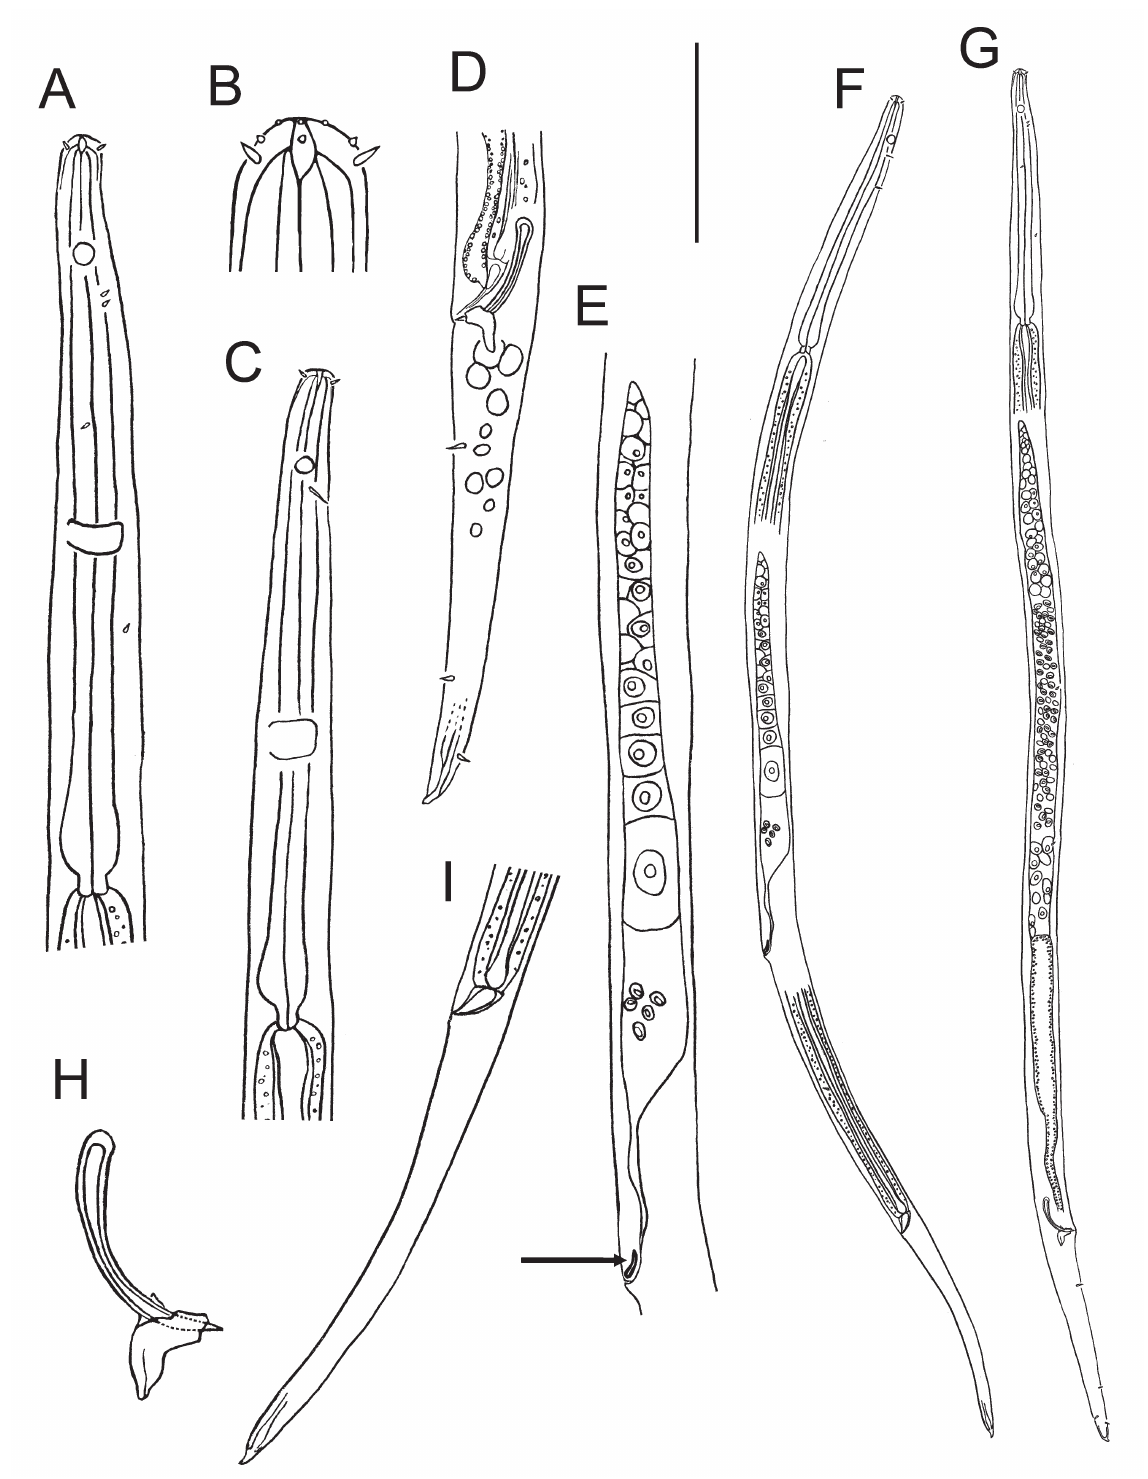
Fig. 6. Monhystrella kermadecensis sp. nov. A . Male anterior body region. B . Male head region. C . Female anterior body region. D . Male posterior body region. E . Female reproductive system. F . entire ♀. G . Entire ♂, holotype. H . Male copulatory apparatus. I . Female posterior body region. Arrow shows position of cuticularised piece anterior to vulva. Scale bar: A, c–e, I = 25 µm; B = 7 µm; F–G = 70 µm; H = 12